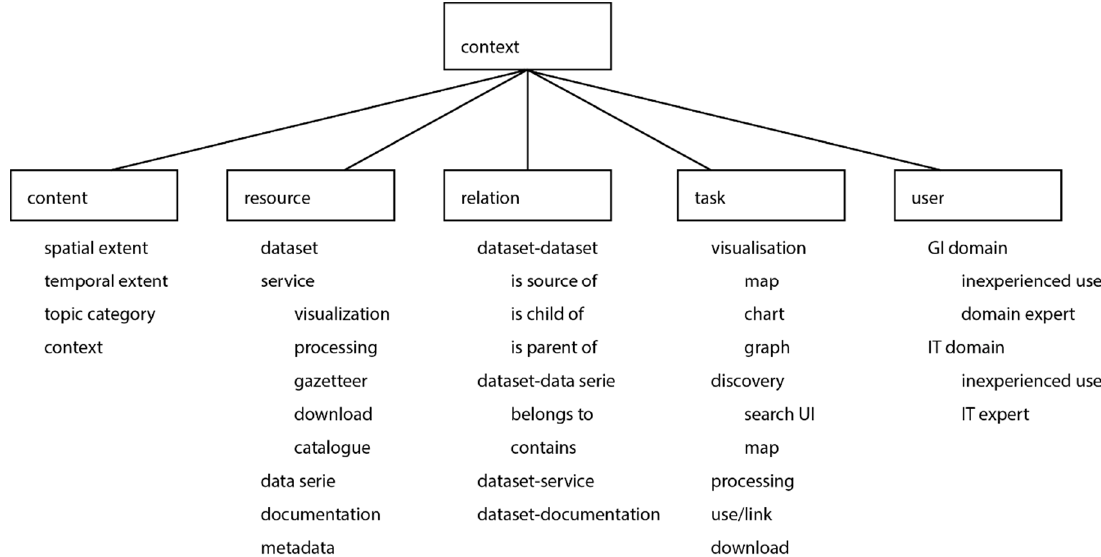
Figure 2. Sub-attributes of the pattern context.